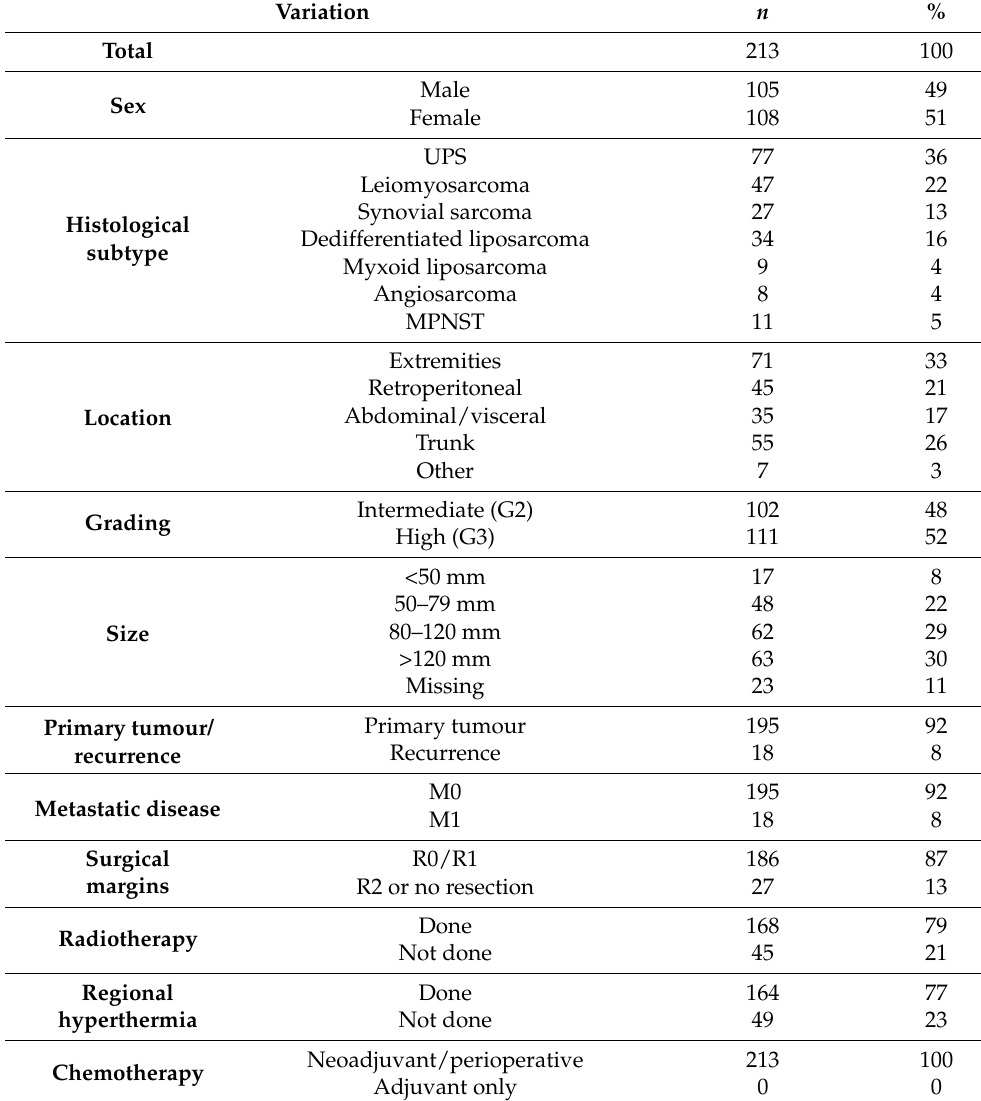
Table 1. Patients’ baseline characteristics. UPS: undifferentiated pleomorphic sarcoma; MPNST: malignant peripheral nerve sheath